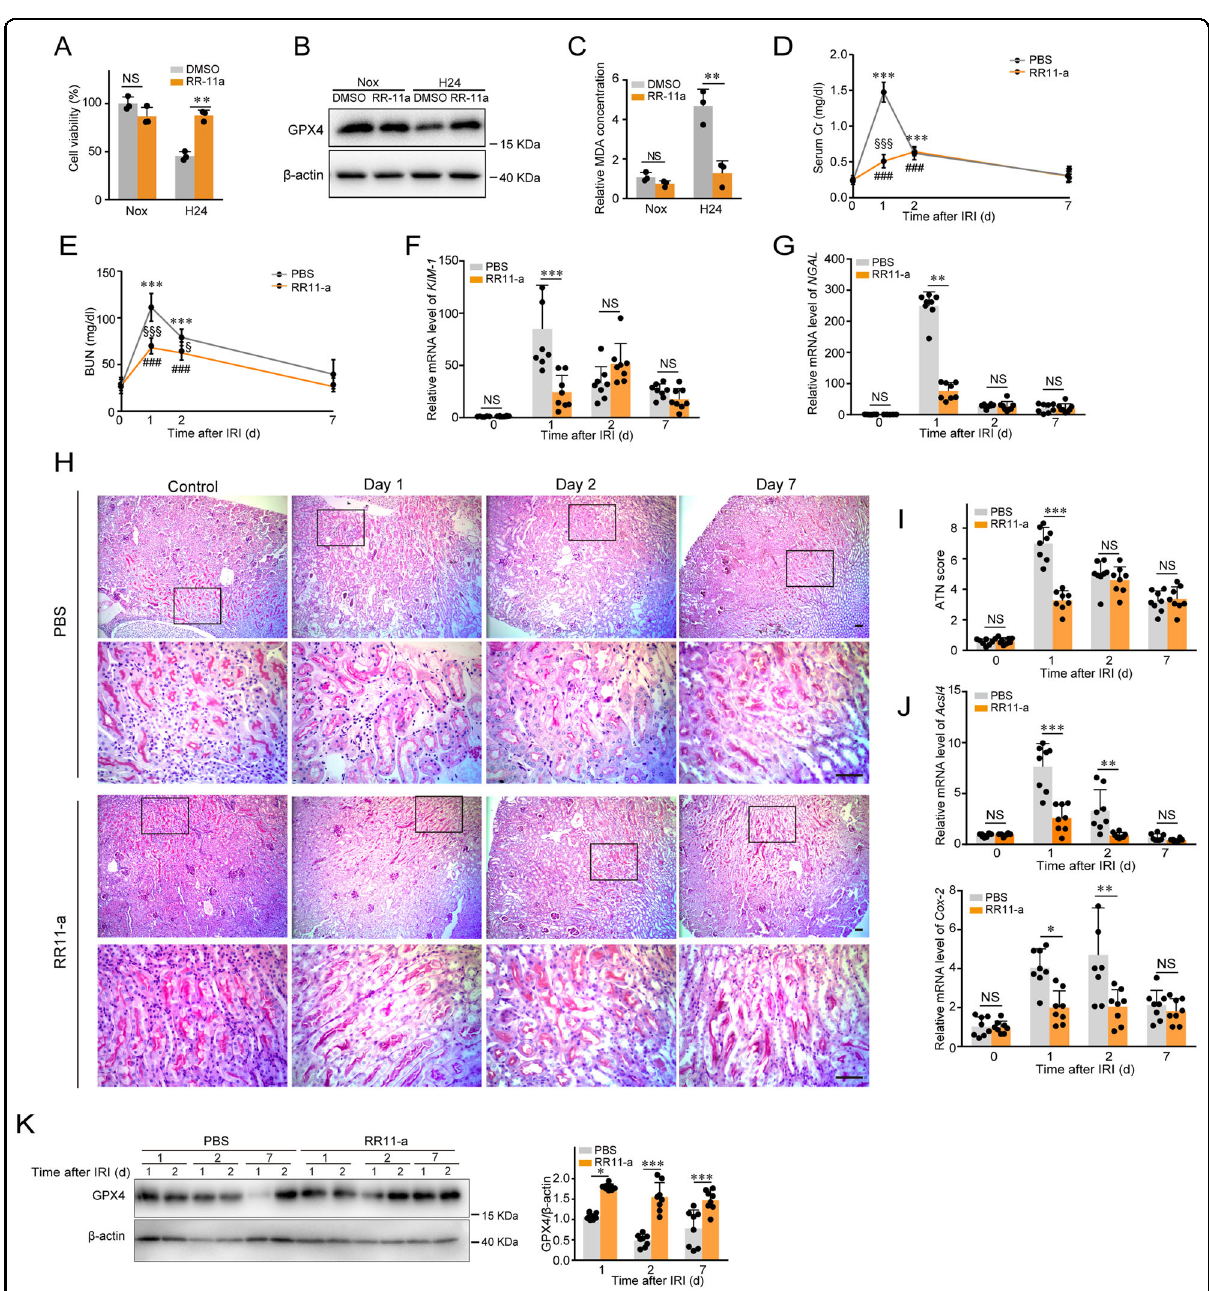
Fig. 7 Legumain inhibitor RR-11a attenuates ferroptosis and tubular injury induced by IRI. Primary lgmn WT mRTECs were pretreated with RR- 11a (100nM) for 2 h before incubating under hypoxic conditions for 24 h. A Cell survival was measured by CCK-8 assays. B Western blot assay of GPX4. C Lipid peroxidation levels were measured by MDA assay. Lgmn WT mice were i.p. injected with RR-11a or the vehicle control at 40 min before bilateral ischemia ( n = 8). Kidneys and serum were collected before and at day 1, 2, and 7 after IRI. D , E Renal functions assessed by serum creatinine and BUN levels. ** P < 0.01, *** P < 0.001 versus vehicle control group before IRI; ♯♯ P < 0.01, ♯♯♯ P < 0.001 versus RR-11a group before IRI; § P < 0.05, §§ P < 0.01, §§§ P < 0.001 versus vehicle control group after IRI at the corresponding time point. F , G Quanti fi cation of kidney KIM-1 and NGAL mRNA levels by qPCR. H Each pair of images includes a representative PAS-stained histologic photomicrograph of the kidney (top) and higher-magni fi cation photomicrographs of the renal cortex (bottom; corresponding to the boxed area). Scale bar, 50 μ m. I Quanti fi cation of acute tubular necrosis. J Quanti fi cation of kidney Acsl4 and Cox-2 mRNA levels by qPCR. K Western blot assay using the antibody against GPX4. Right panel shows the statistical data. Data were collected from three independent experiments. All data are expressed as the mean ± SD. ** P < 0.01; two-way ANOVA. All data are expressed as the mean ± SD. * P < 0.05 , ** P < 0.01, *** P < 0.001; two-way